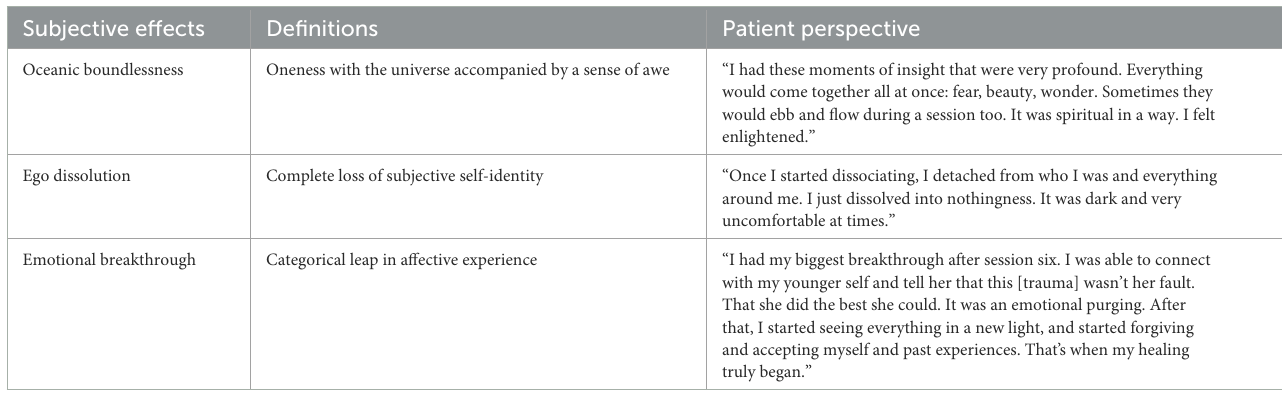
TABLE 2 Subjective